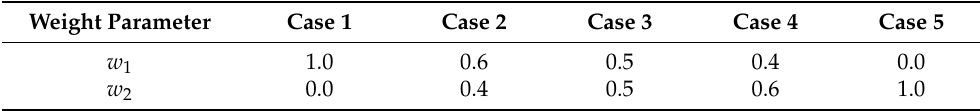
Table 5. Weight parameters in different cases of window